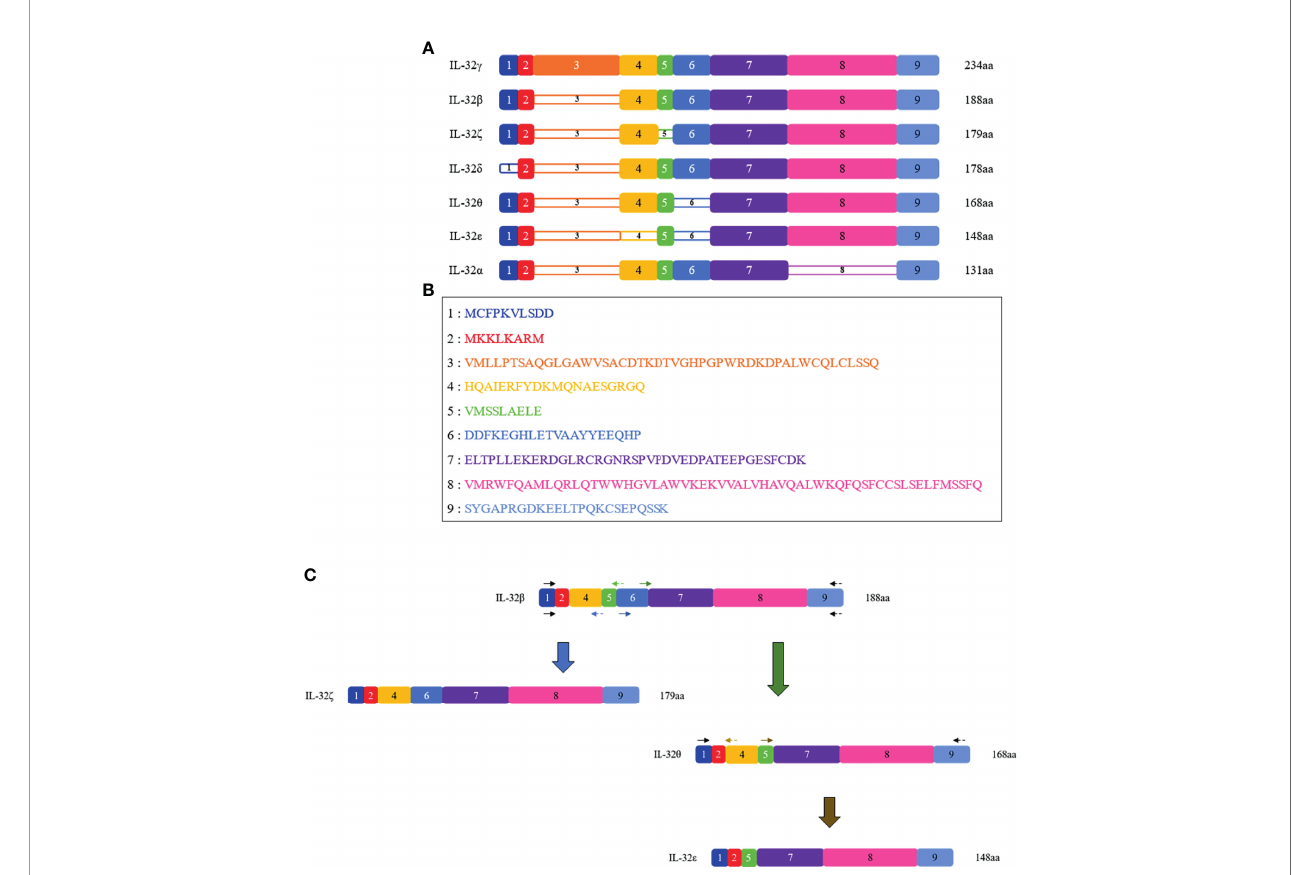
FIGURE 1 | Schematic representations of the seven IL-32 isoforms. (A) Seven isoforms of IL-32 are shown with their present/absent domains. The name of each isoform is shown on the left, and their length in amino acid (aa) is on the right. The colored, numbered box represents exons from 1 to 9, numbered in line with the order of N-terminal; dense-colored boxes are indicated for the existing exons and decolored boxes for the absent exon. Starting from the longest isoform, IL-32 g isoform is represented on the top as it is the longest variant with 234 amino acid residues and the only one that contains all 9 exons, while on the bottom the shortest variant is present, which is IL-32 a isoform with 131 amino acid residues. (B) Amino acid sequence of each exon. (C) Schematic PCR-based construction of IL-32 z , IL-32 q , and IL-32 ϵ ; using IL-32 b as a template, IL-32 z and q were built. Next, using IL-32 q as a template, IL-32 ϵ was built. The black arrows represent outer primers and are the same in all constructs; the blue, green, and gold arrows represent the inner primers used to build IL-32 z , IL-32 q , and IL-32 ϵ , respectively. The forward primers are indicated as solid arrows, while the reverse primers are indicated as dashed